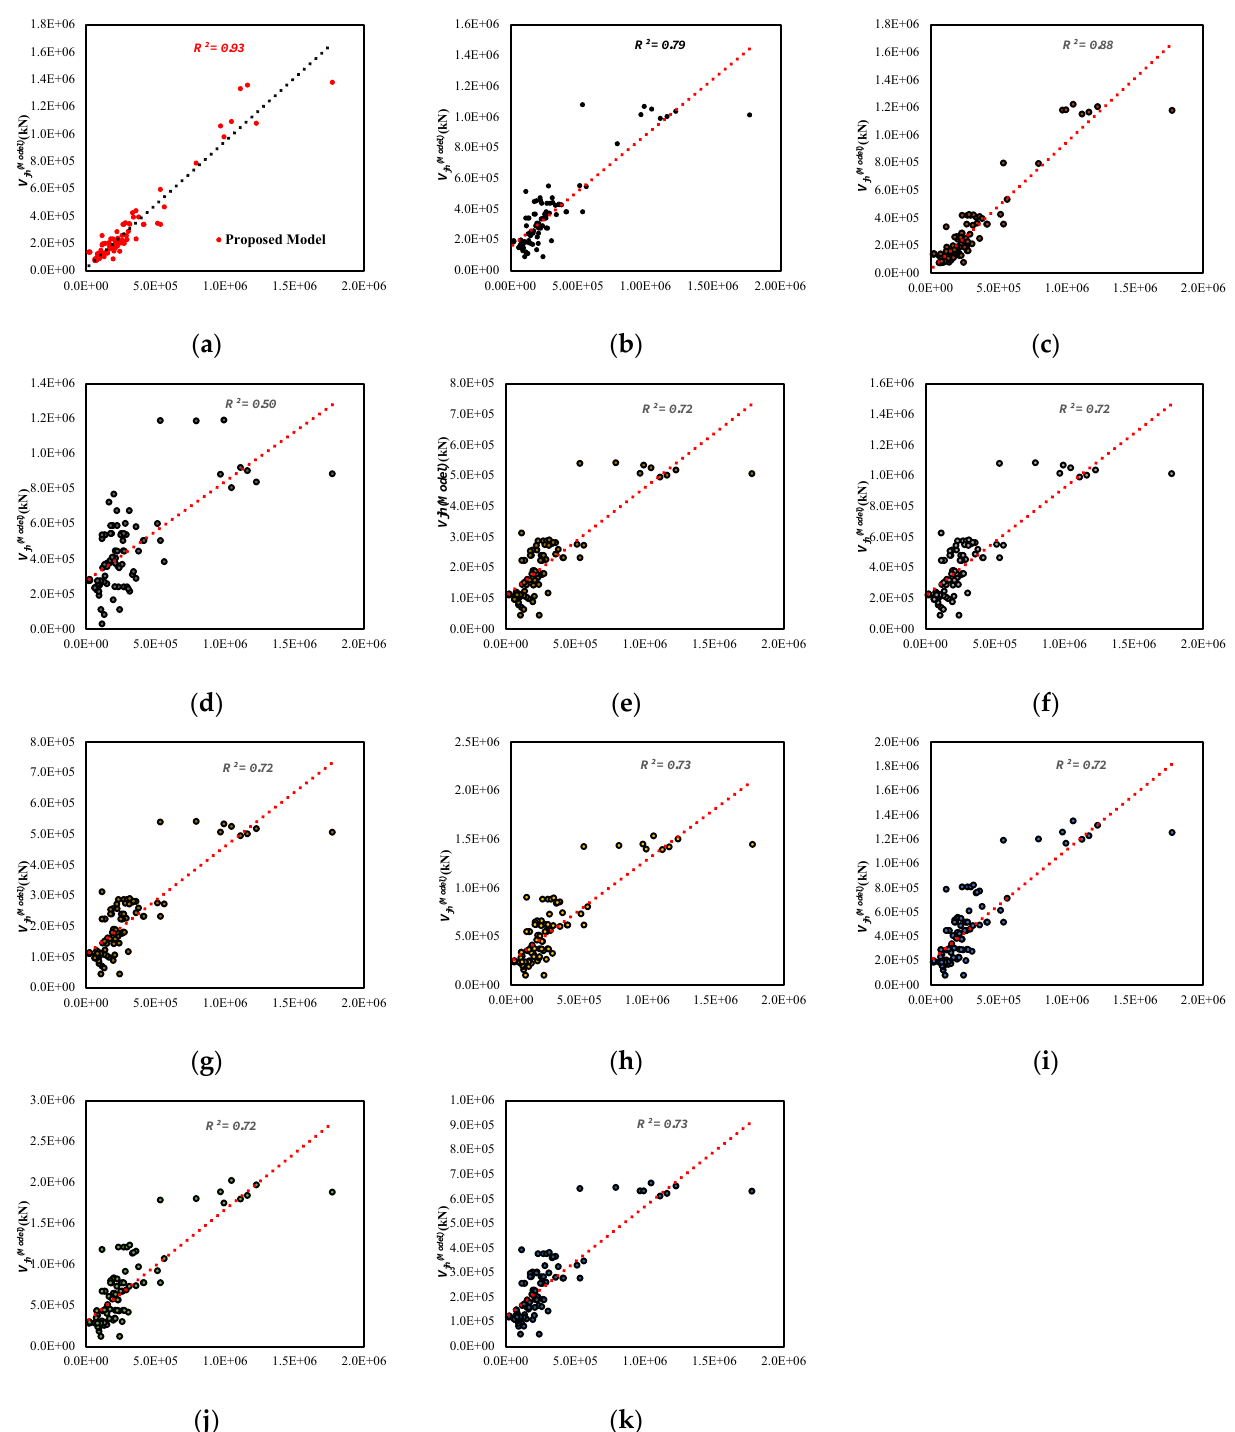
Figure 9. Comparison of the unreinforced RC exterior joint: ( a ) Proposed Equation, ( b ) Vollum et al. [24] ( c ) Bakir et al. [4] ( d ) Montenious et al. [27] ( e ) Kim et al. [28], ( f ) ACI 352R ‐ 02 [22], ( g ) ASCE 41 ‐